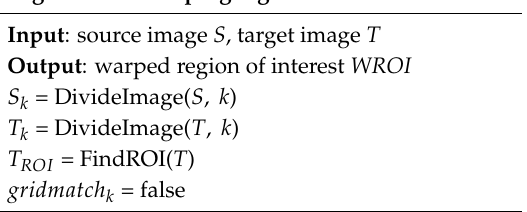
Algorithm 1. Warping